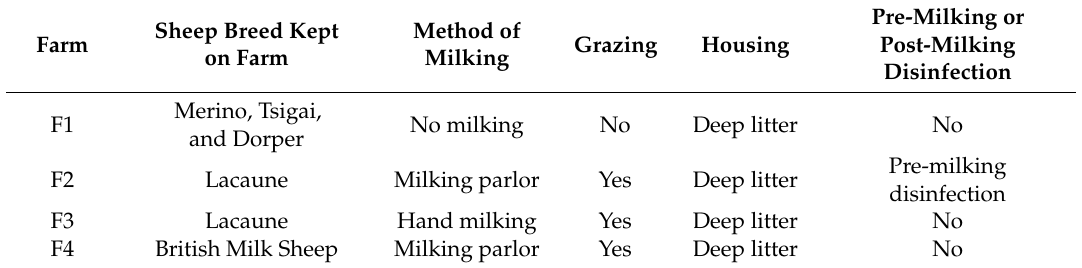
Table 1. Major characteristics of the sheep farms involved in this study.